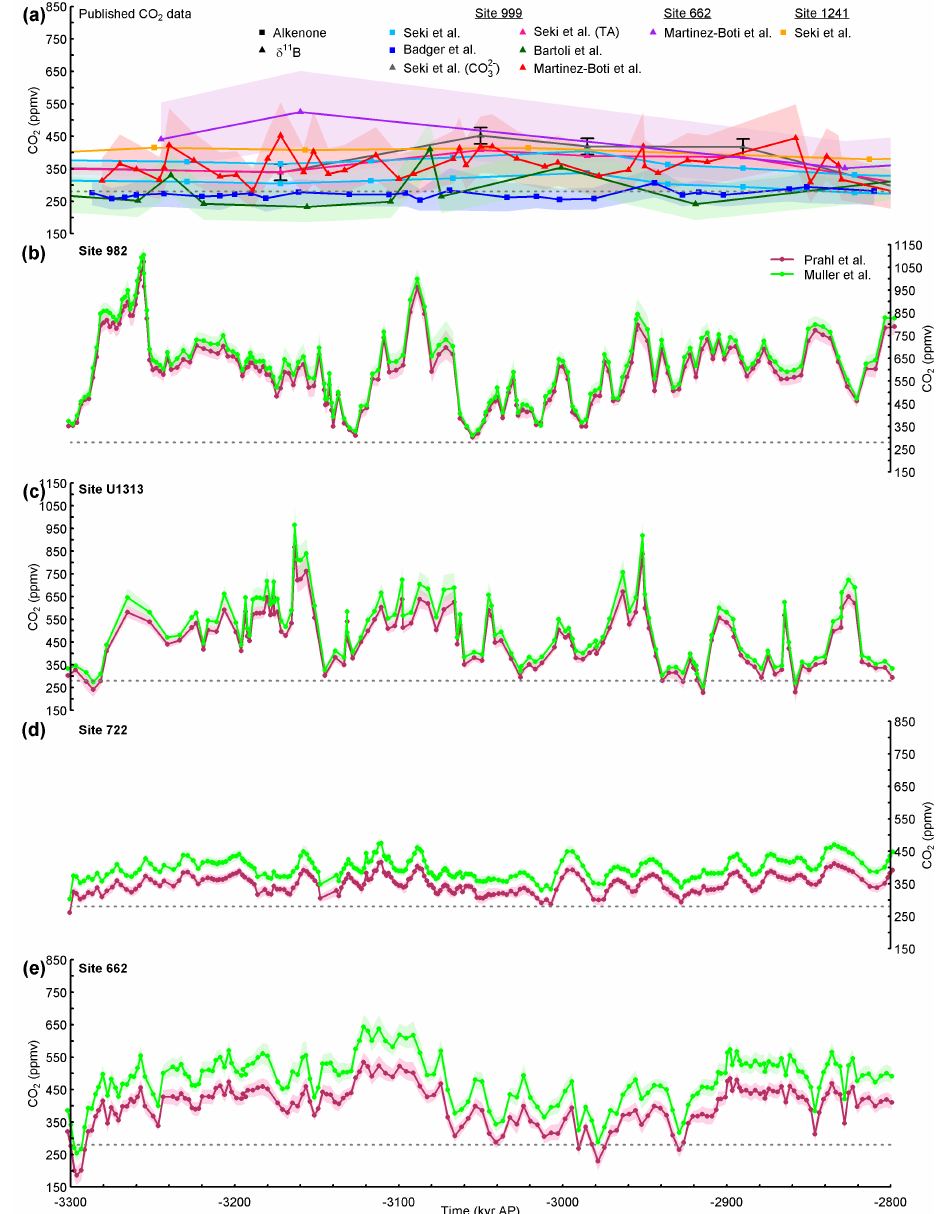
Figure 12. Data–model comparison of atmospheric CO 2 concentration (ppmv) for the period 3300–2800kyrBP (late Pliocene) for six ODP/IODP sites: Site 982 (North Atlantic), Site U1313 (North Atlantic), Site 722 (Arabian Sea), Site 999 (Caribbean), Site 662 (tropical Atlantic) and Site 1241 (east tropical Pacific). (a) Time series of atmospheric CO 2 concentration from selected proxy data records. Shown is CO 2 estimated from alkenone (squares) for Site 999 by Seki et al. (2010) (light blue) and Badger et al. (2013) (dark blue) and for Site 1241 by Seki et al. (2010) (orange), and estimated from δ 11 B (triangles) for Site 999 by Seki et al. (2010) based on modelled carbonate concentration ([CO 2 − ]) (grey) and assuming modern total alkalinity (TA, pink), Bartoli et al. (2011) (dark green) and Martinez-Boti et al. (2015) (red) and 3 for Site 662 by Martinez-Boti et al. (2015) (purple). For the Seki et al. (2010) δ 11 B records, error bars are ± 25ppmv and the error band is the result of varying the modern TA by ± 5%, whilst for Martinez-Boti et al. (2015) the error band represents the 95% confidence interval for a 10000 member Monte Carlo analysis. (b) – (e) Time series of atmospheric CO 2 concentration estimated from SST proxy data (circles; Herbert et al., 2010 – Sites 662 and 722; Naafs et al., 2010 – Site U1313; Lawrence et al., 2009 – Site 982) calibrated using the method of Prahl et al. (1988) (maroon) and the method of Muller et al. (1998) (light green). CO 2 is calculated based on a linear relationship between emulated grid box mean annual SAT (modelled using the lowice emulator) and CO 2 for three constant CO 2 scenarios of 280, 350 and 400ppmv. Error bands represent estimated atmospheric CO 2 concentration taking into account the emulated grid box posterior variance (1SD). Where the error appears to be very low, this is generally an artefact of the way that the data have been plotted. The pre-industrial CO 2 concentration of 280ppmv (grey dotted line) is included for